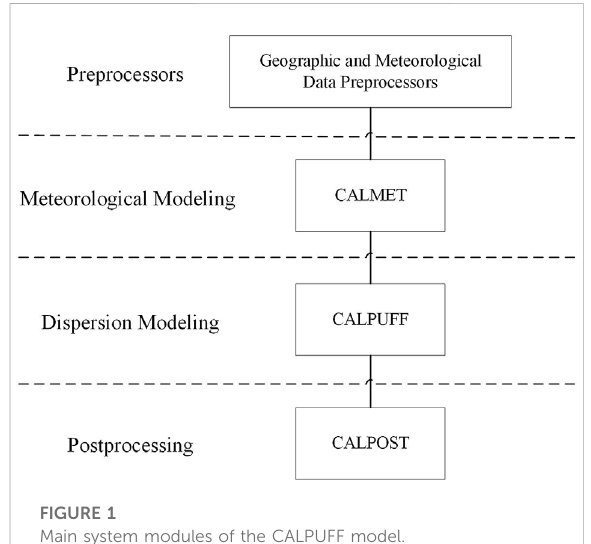
FIGURE 1 Main system modules of the CALPUFF model.